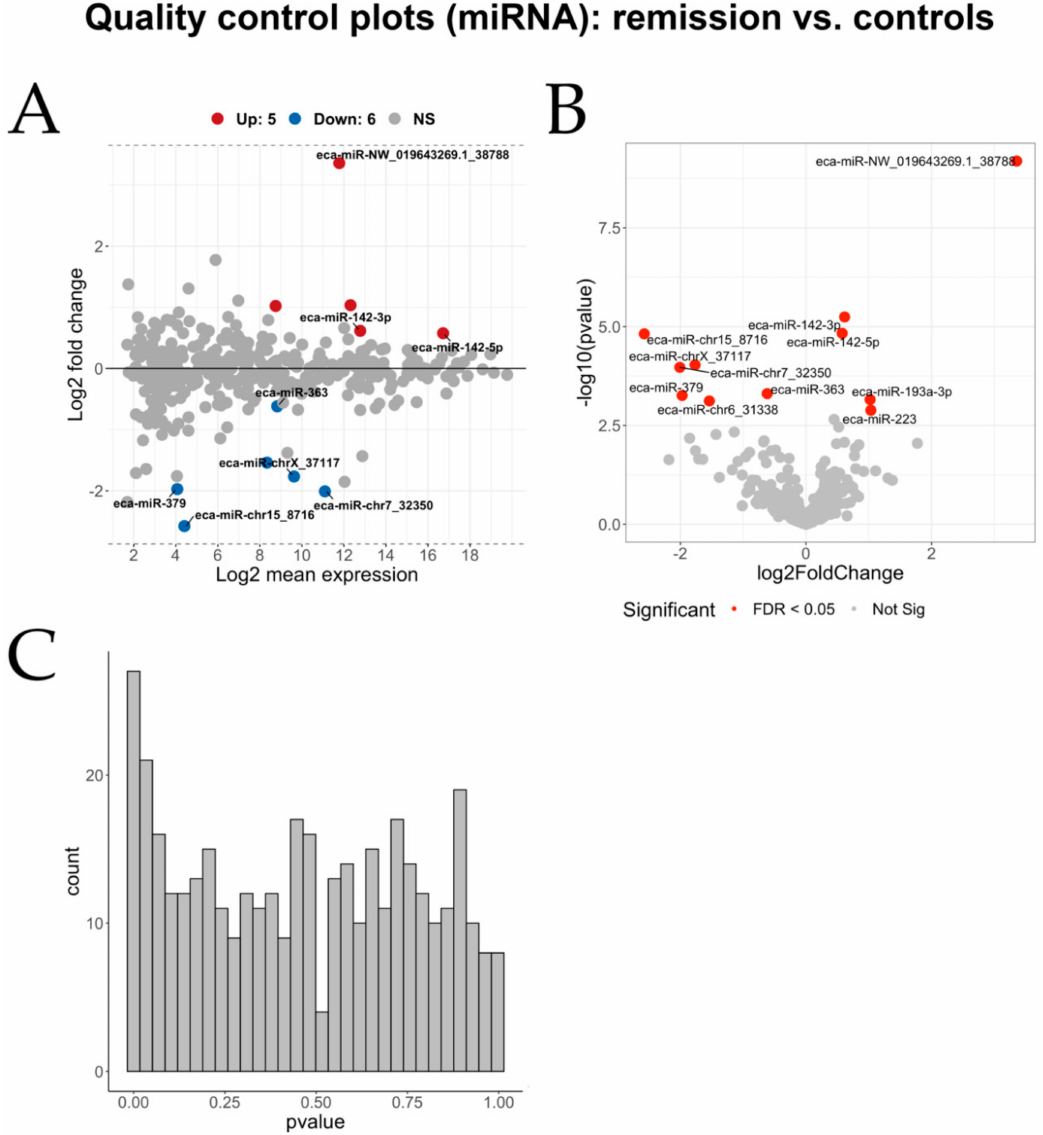
Figure A3. Quality control plots for the di ff erential miRNA expression analysis using the contrast of horses in remission vs. healthy control horses. An MA-plot ( A ), a Volcano plot ( B ), and a histogram of the obtained p -values ( C ) are shown. Non-significant (NS) miRNAs are indicated in grey